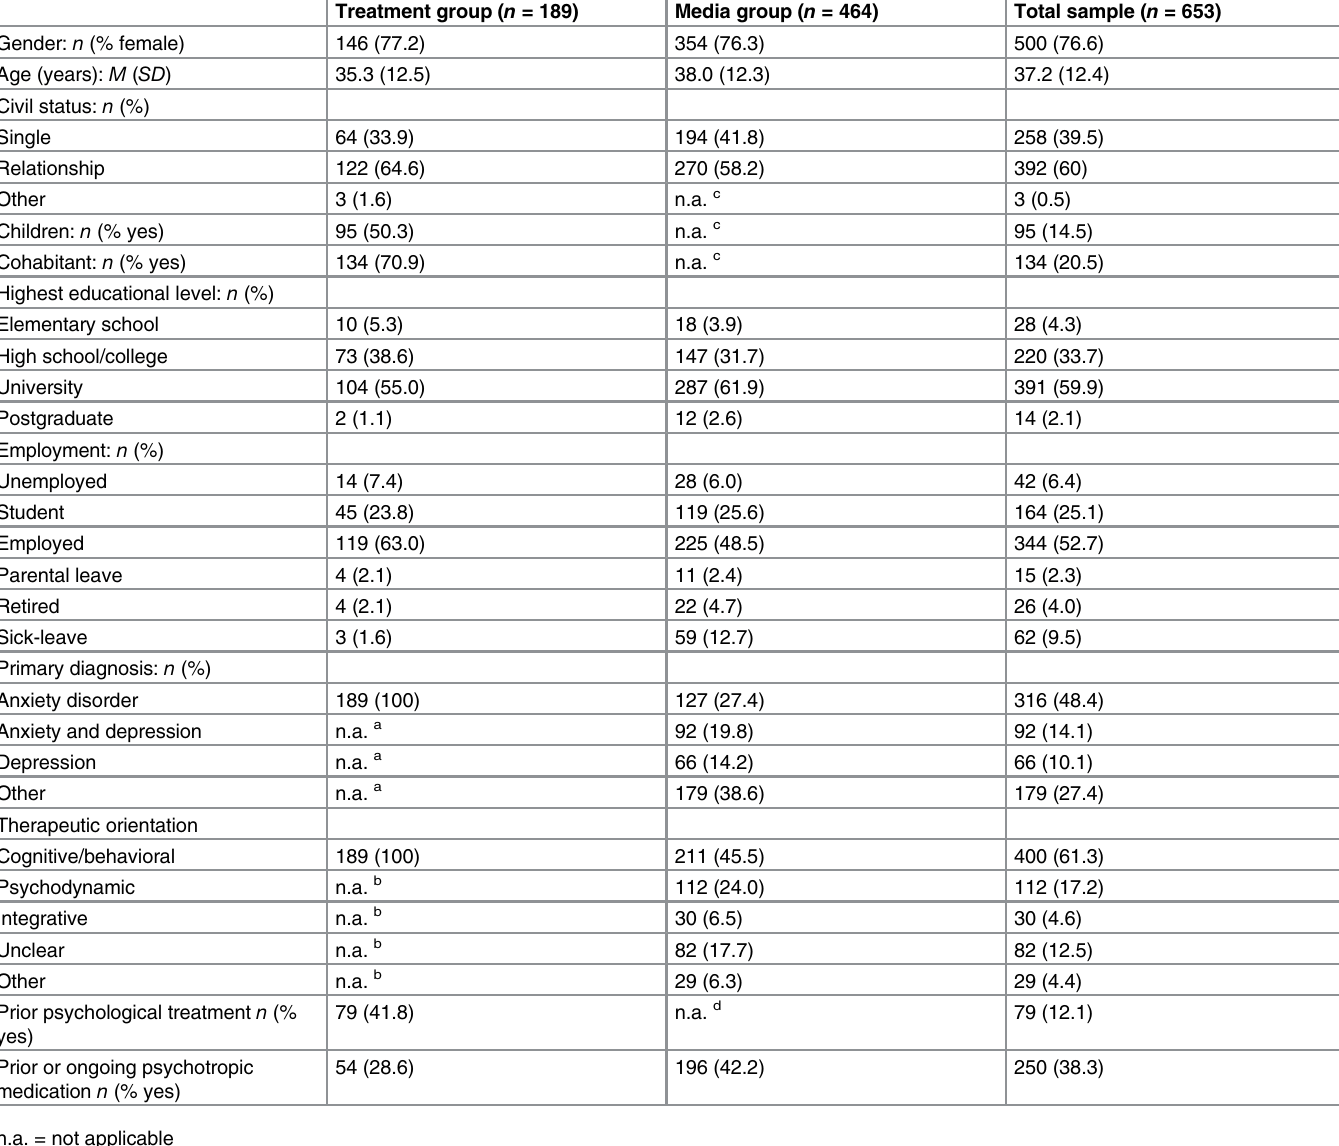
Table 1. Sociodemographic characteristics of participants divided by means of